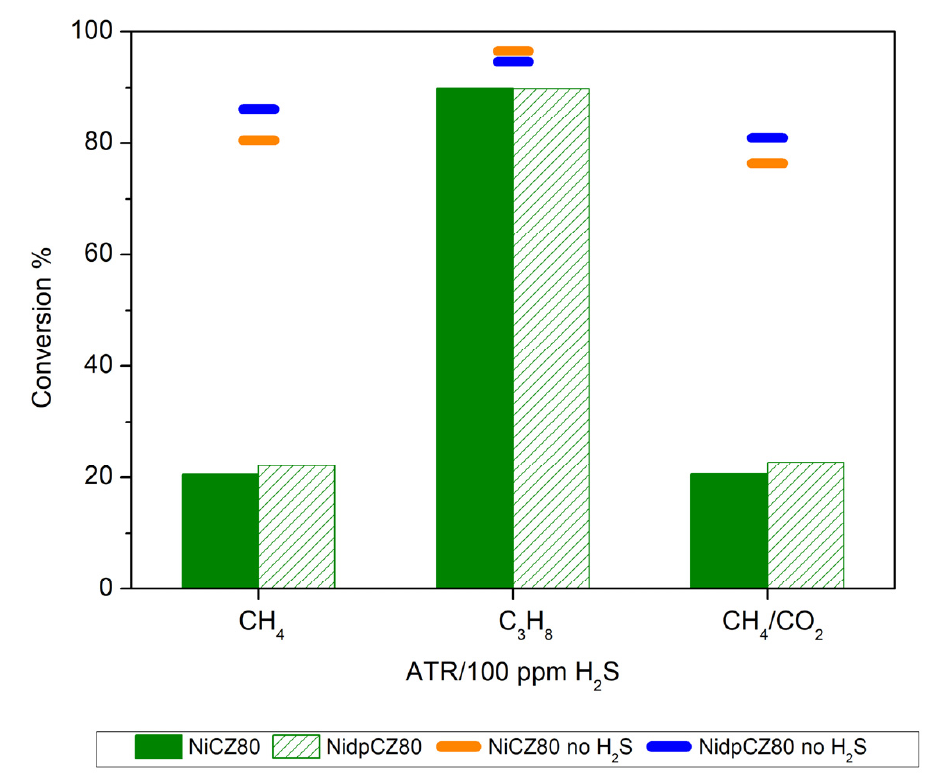
Figure 11. Conversion of different fuels in ATR conditions at T = 800 °C GSVH = 12,000 h − 1 over undoped and doped catalysts.